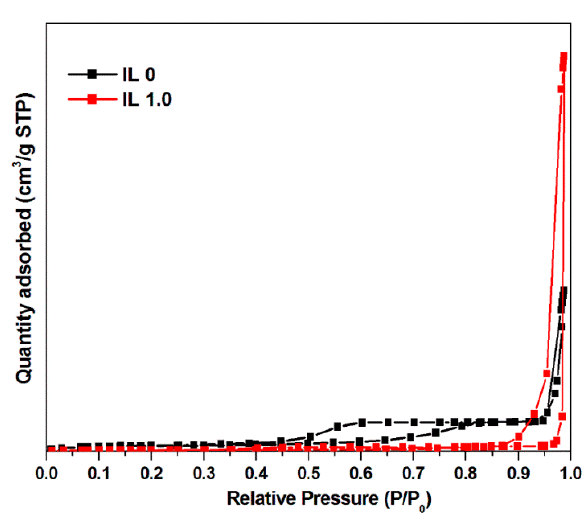
Figure 2. N 2 adsorption/desorption isotherm plot for the prepared gel samples.